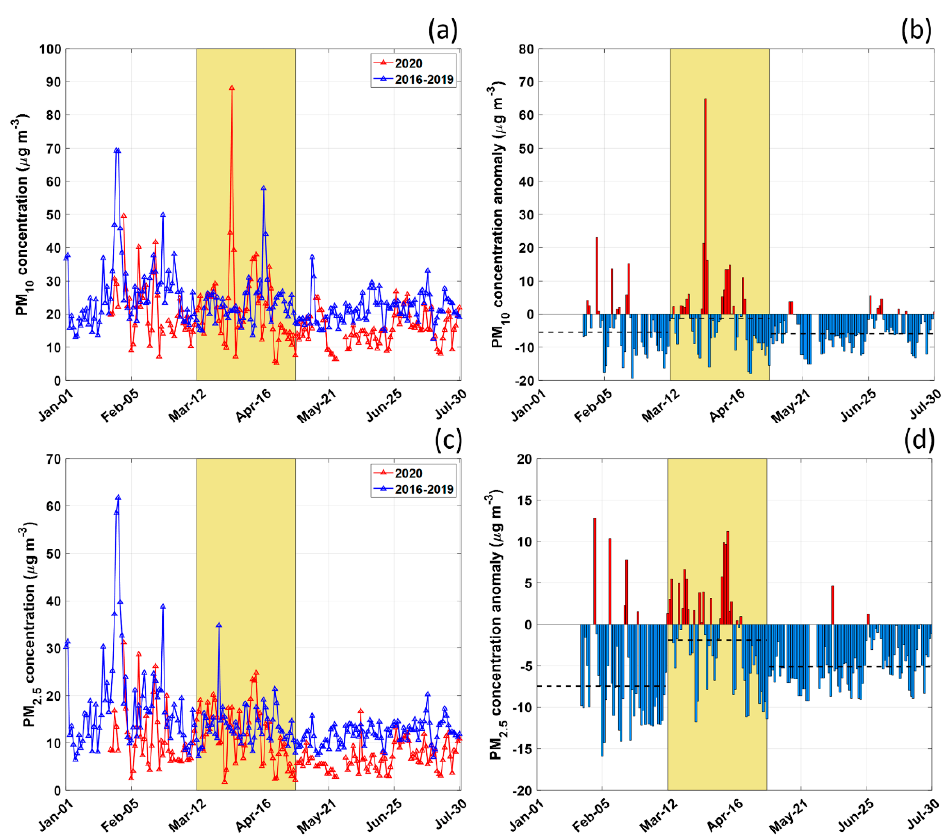
Figure 2. Time series of daily ( a ) PM 10 and ( c ) PM 2.5 concentrations for the measurement period from January to July 2020 and the corresponding period in the years 2016–2019. Anomalies for each day are calculated from the difference with a baseline value (mean concentration level for each phase of the period 2016–2019) for ( b ) PM 10 and ( d ) PM 2.5 . The lockdown period is evidenced by a yellow